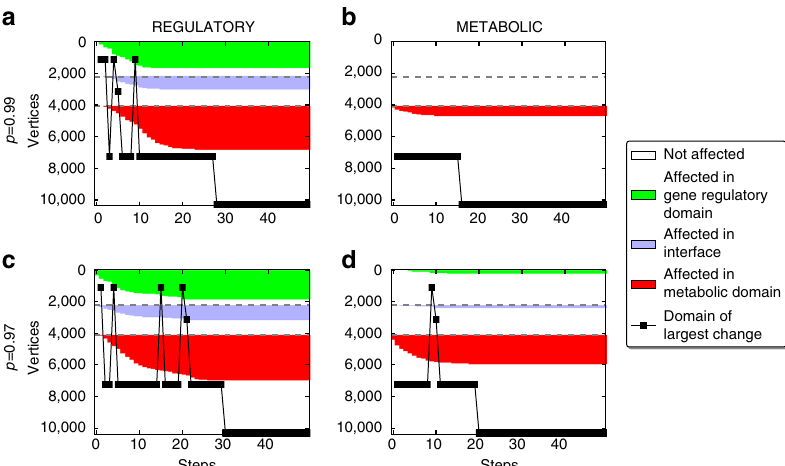
Fig. 3 Sample trajectories of the integrative E. coli network. Initial perturbations differ in size, q = 1 − p = 0.01 ( a , b ) and q = 0.03 ( c , d ), as well as in localization: perturbations are initiated in the gene regulatory domain ( a , c ) and the metabolic domain ( b , d ). In each panel, the vertex states are plotted against the update steps according to Eqs. (1) and (2). The vertices are grouped according to the domain af fi liation, starting from gene regulatory domain ( top , green ) via protein-interface domain ( middle , blue ) towards metabolic domain ( bottom , red ). Within each domain they are arranged with respect to the update step, in which they were affected in the respective run (vertex ordering within the domains is thus different from run to run). Affected vertices are shown in the color of their domain, unaffected vertices are shown last for each run and in white . The horizontal dashed lines denote the domain boundaries and the black square indicates the domain with the largest number of newly affected vertices in each step. Connections between black squares are only shown to guide the